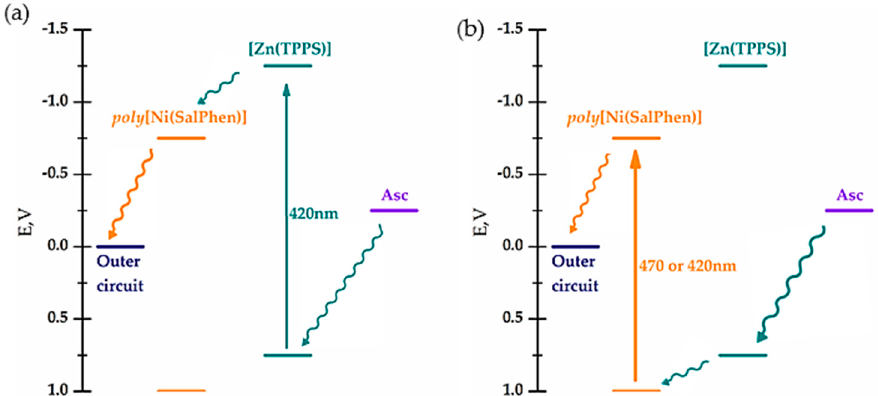
Figure 6. Plausible mechanism of ascorbate oxidation on the poly [Ni(SalPhen)]:[ZnTPPS] photoanode for ( a ) excitation of porphyrin or ( b ) excitation of NiSalen